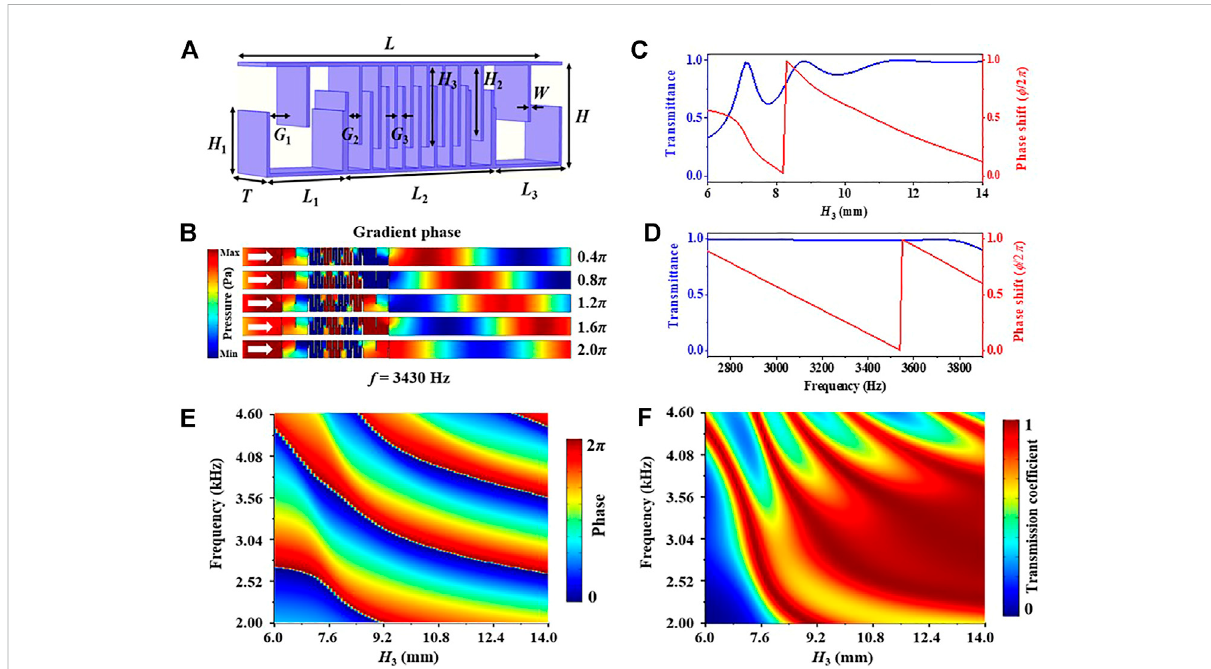
FIGURE 1 (A) The three-dimensional schematic of LS. (B) The acoustic pressure distributions of the LS with different interdigital length ( H 3 = 13.30 mm, 11.53 mm, 10.12 mm, 8.97 mm, 8.30 mm) at 3,430 Hz. (C) The relation between the interdigital length and transmission information (transmittance and phaseshift)for LS. (D) The relation between theoperatingfrequencyand transmission information (transmittanceand phase shift)for LS. (E) The relation between phase shift and incident frequency with the increase of parameter H 3 . (F) The relation between transmission coef fi cient and incident frequency with the increase of parameter H 3